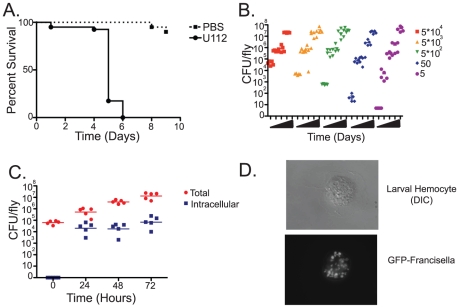

Francisella novicida is capable of infecting Drosophila.Wild-type flies were injected with F. tularensis novicida U112 and survival and growth were monitored over the course of the infection. (A) Survival of wild-type flies following injection of 103 CFUs of F. novicida. Median-time-to death (MTD) is approximately five days post infection when incubated at 29°C. Log-rank analysis of the Kaplan-Meyer survival curves showed statistical significance with a P value of <0.0001. Figure S1 provides variance data for these and other survival curves. (B) Growth of F. novicida in wild-type flies. Injection of a range of initial doses between 5 and 5*104 CFUs per fly results in bacterial growth to up to approximately 5*107 CFU per fly within 4–5 days post-infection at 29°C. (C) Intracellular and extracellular populations of bacteria within the fly following infection with 5*103 CFU/fly, as determined by survival of bacteria within cells following injection of the non-cell-permeable antibiotic gentamycin. Horizontal lines indicate mean CFU/fly. (D) GFP expressing F.novicida within a larval hemocyte.